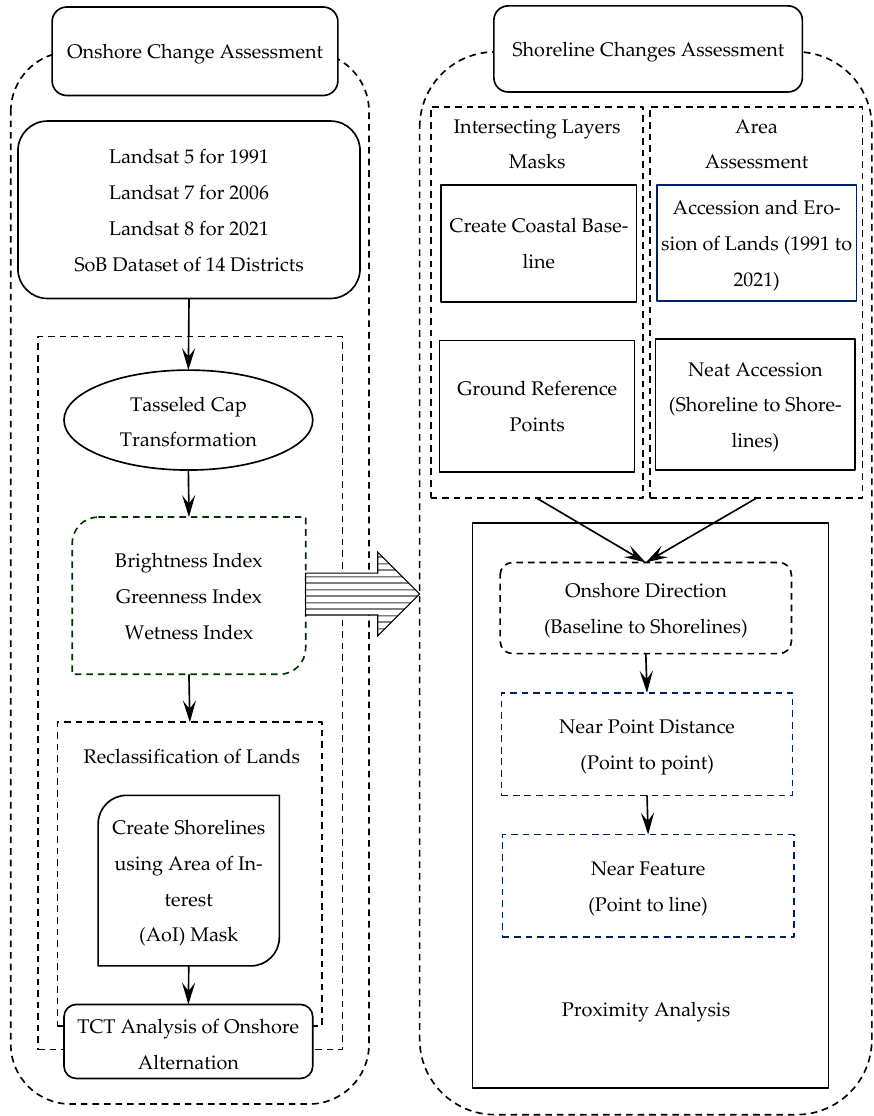
Figure 1. Research framework for determining onshore change and shoreline change assessments.